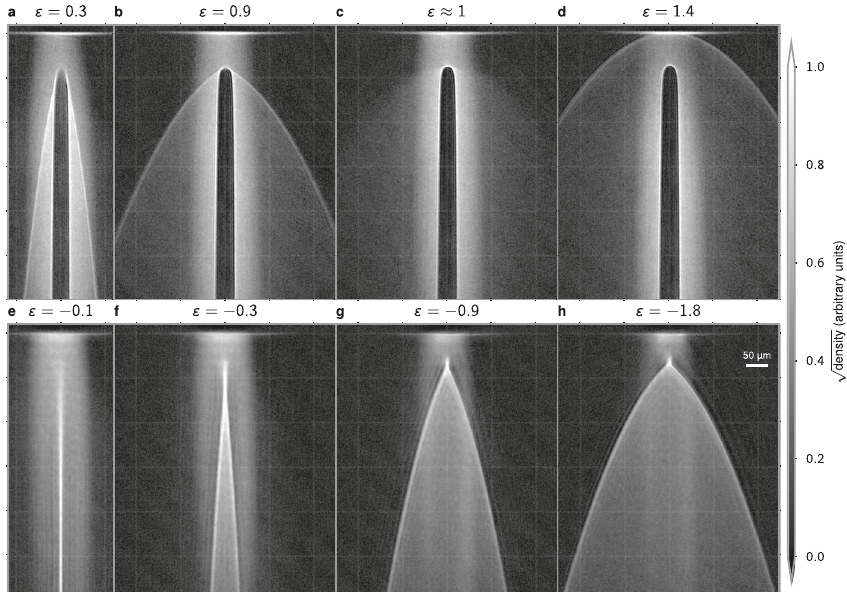
Fig. 3 Experimental observation of fl ow with repulsive or attractive potentials. a – d A repulsive potential is centered h = 78(1) μ m below the trapped BEC. e – h An attractive potential is centered h = 46(1) μ m below the trapped BEC. Individual panels are labeled by the energy ratio ϵ as de fi ned in the main text. All images have been averaged over 6 independent experimental images with the same parameters. A faint grid is overlaid at 100 μ m increments. The scale for square root of the density has been set so that pure white corresponds to the 99.95th percentile over all images to emphasize the caustic structure. The slight fringing seen in the images is due to optical effects in the imaging system, not matter-wave interference.